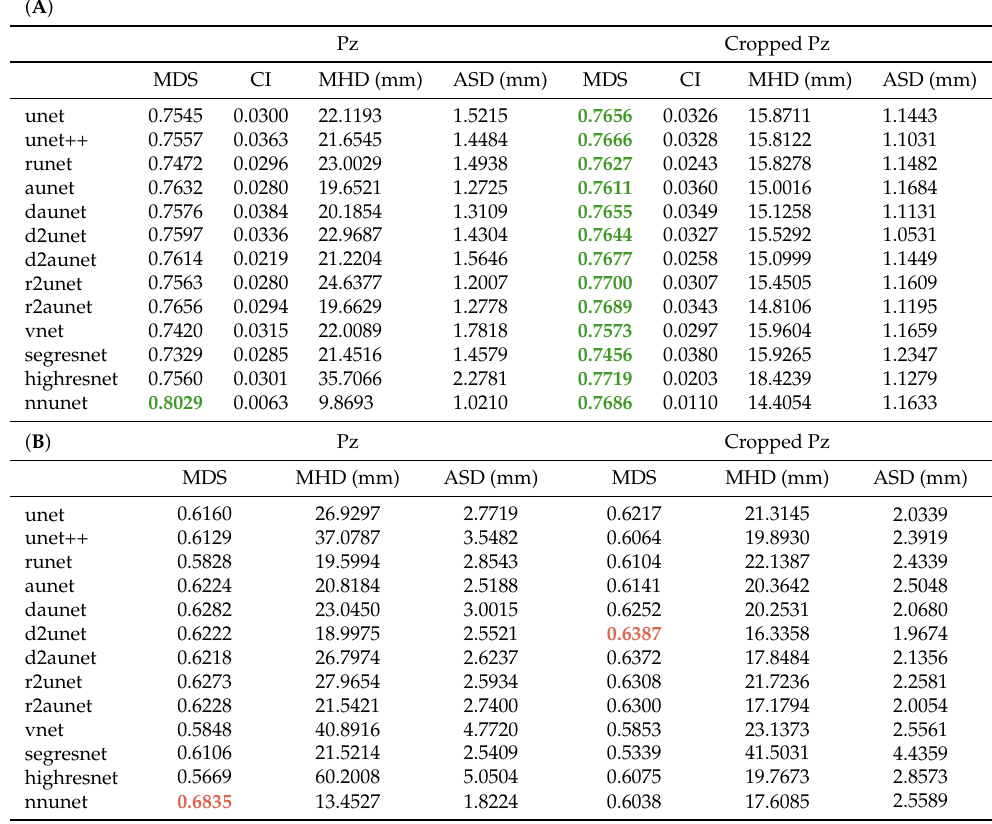
Table 3. ( A ) Results obtained on the external test set by the segmentation models trained on the peripheral zone segmentation task. The results presented are the mean scores of the 5-fold models over all the samples on the external test set. The best results (based on Table A3) for both the full and cropped volumes are presented in green. ( B ) Results obtained by the segmentation models on the peripheral zone segmentation task. The results presented are the mean scores from the validation data over the five folds. The best results for both the full and cropped volumes are presented in